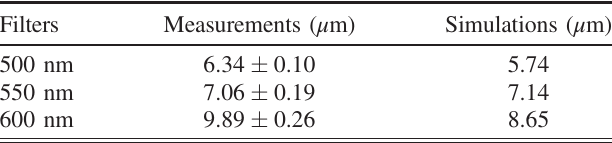
TABLE II. Distance between peaks at the best focus for measurements and simulations and for three